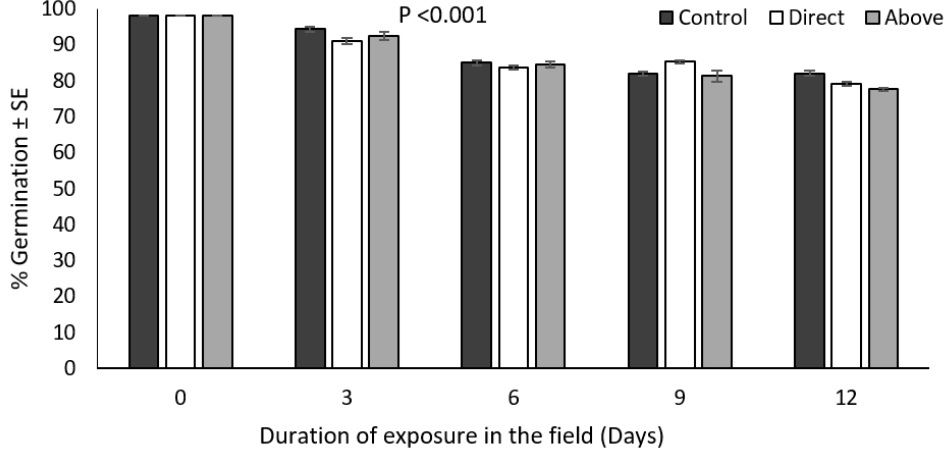
Figure 4. Effect of exposure. Duration and placement position of ( R )-lavandulyl 3-methylbutanoate (used with autoinoculation device) on M. anisopliae viability under realistic field condition.